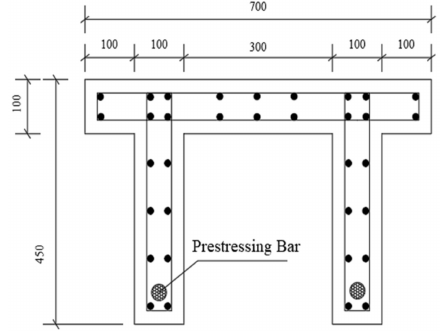
Figure 1. Model dimensions.